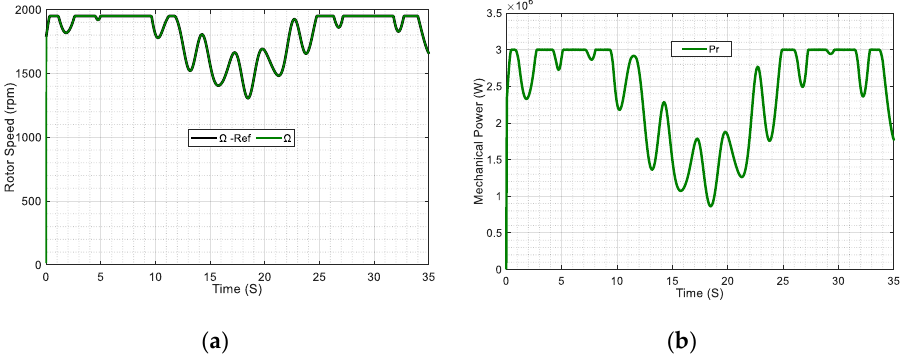
Ω ); ( b ) mechanical power ( 𝑃 Figure 10. ( a ) Rotor speed ( Ω ); ( b ) mechanical power ( 𝑃 𝑟 ) of the DFIG. 𝑟 ) of the DFIG. Figure 10. ( a ) Rotor speed ( ); ( b ) mechanical power ( P r ) of the DFIG. Figure 10. ( a ) Rotor speed (